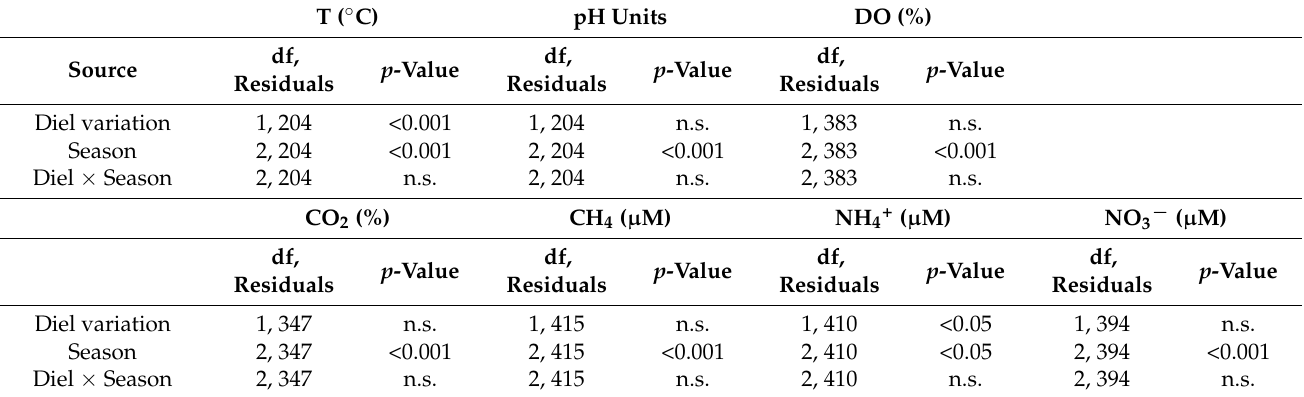
Table 1. Summarized results of the two-way ANOVA on physicochemical parameters (diel variation and season as fixed factors; sampling site as random factor). Results refer to seasonal 24 h-cycle campaigns carried out at 15 vegetated sites of LAC Lake.